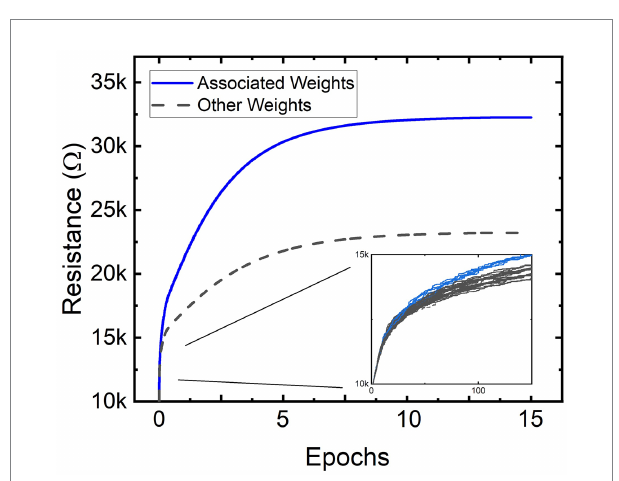
FIGURE 9 Resistances of all the non-volatile memristors within the memristive PILL architecture being trained via multiple epochs. The separation of resistance states is indicative of successful training. Since there are only two groups of weights (resistances), two colors are used to represent two resistance values for associated and non-associated